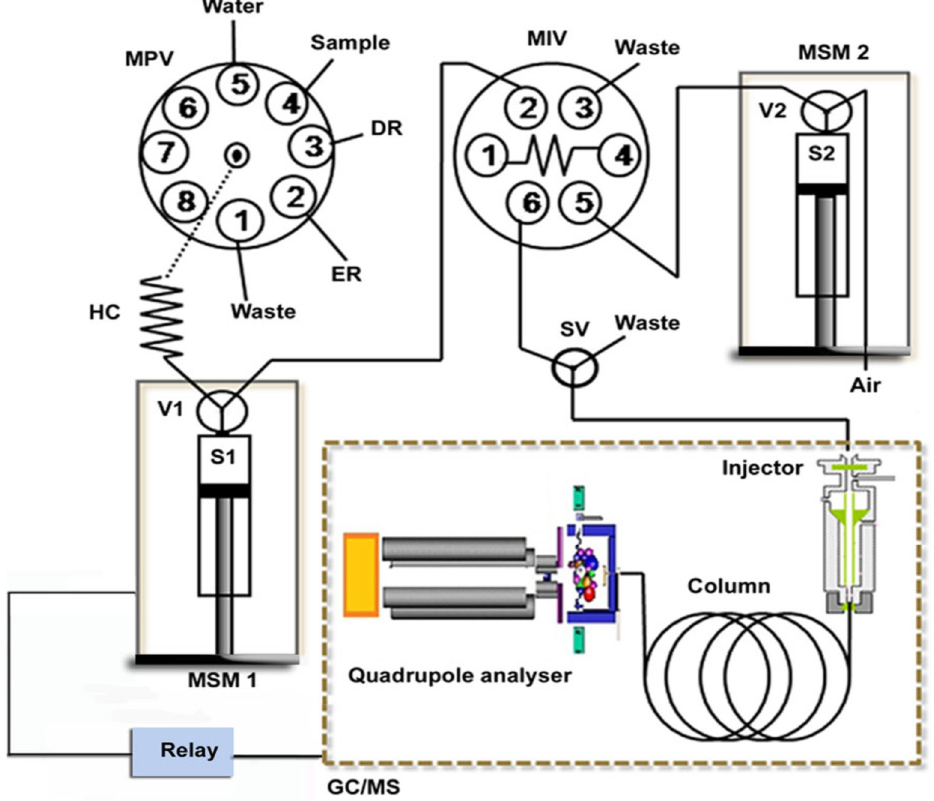
Figure 13. Schematic illustration of the in-syringe-DLLME–GC/MS setup for on-line preconcentration and determination of phthalates. DR: dispersive reagent (acetone), ER: extraction reagent (trichloroethylene), HC: holding coil, MIV: microinjection valve, MPV: multiposition valve, MSM1–2: multisyringe module 1–2, S1–2: syringe pump 1–2, SV: solenoid valve and V1–2: valve 1–2 [48].